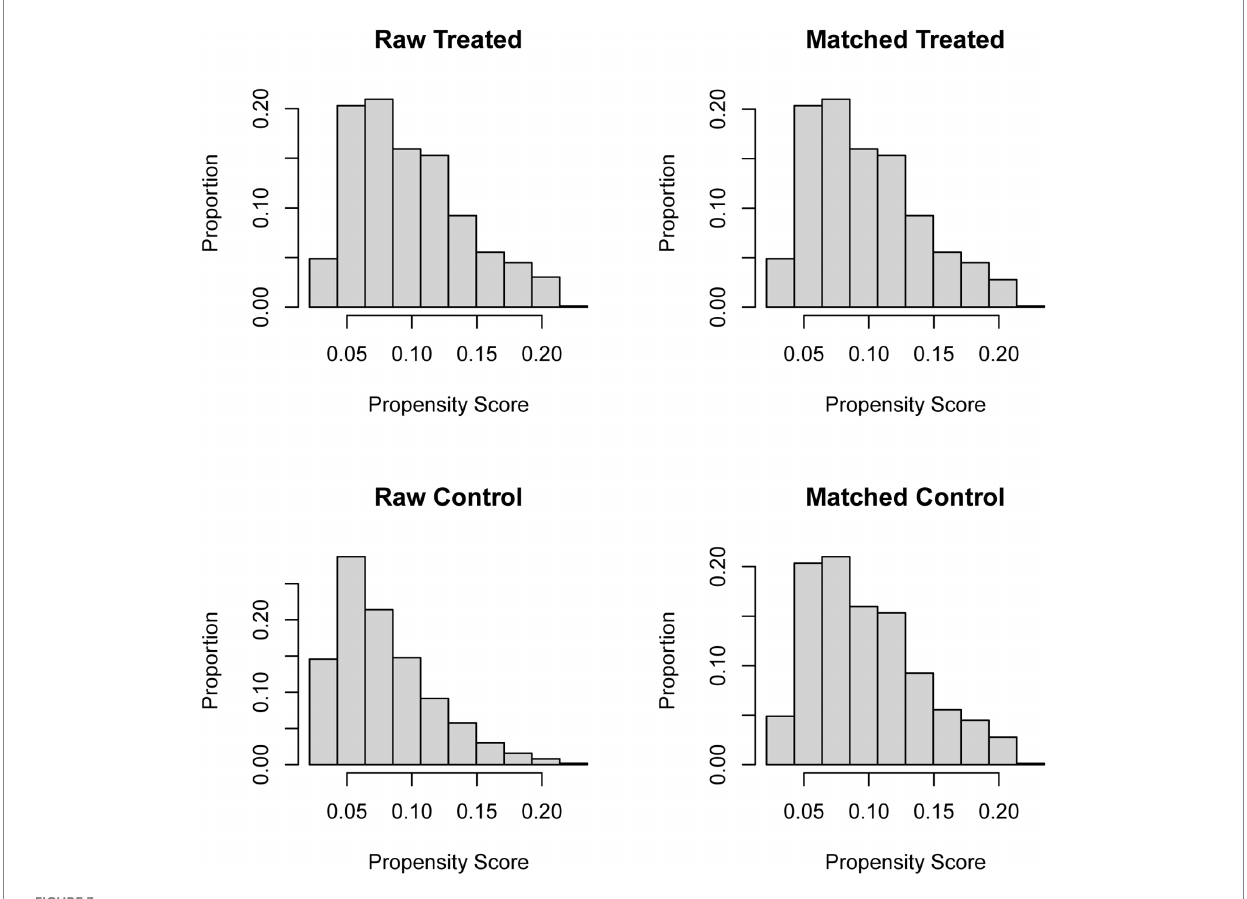
FIGURE 3 Distribution of propensity score before and after